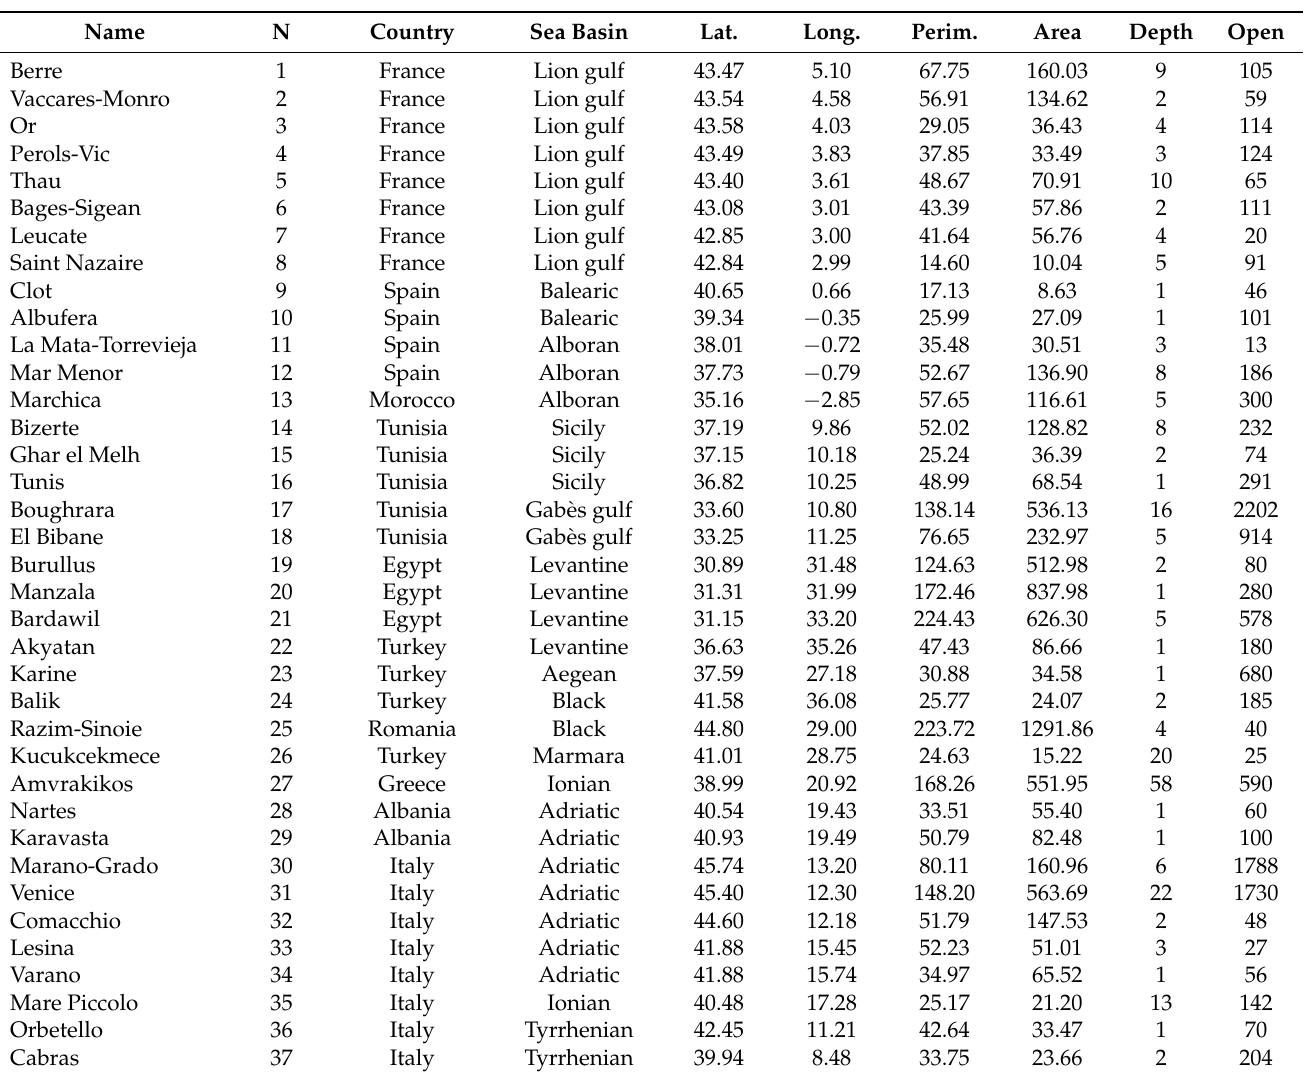
Table 1. Location of the main coastal lagoons of the Mediterranean Sea Basin, indicating their name, numerical code (N) in Figure 3, country where they are located, sub-basin to which they belong (Sea), latitude (Lat), longitude (Long) in decimal degrees, perimeter in km, surface area in km 2 , maximum depth (Depth) in m and width of the opening to the sea (Open) in m.